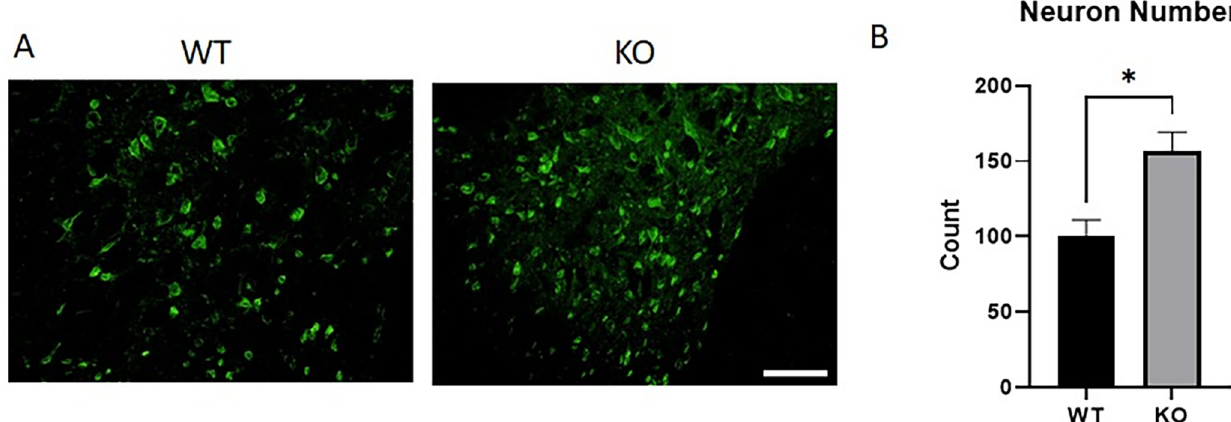
Fig 4. Neuronal viability in the dorsal horn adjacent to the lesion site was greater with NOX2 KO at 28 days post-injury. NeuN is a typically nuclear neuronal marker and was significantly greater in NOX2 KO injured tissue at 28 DPI. Representative images 0.5mm rostral to the lesion site are shown, and demonstrate that NeuN stain is often cytoplasmic in the WT tissue, while it is more nuclear in the KO tissue, as well as being present in a greater amount in the KO tissue. Bars represent mean +/- SEM. N = 3-4/group. � p < 0.05, unpaired t test. Size bar = 200 μ M.